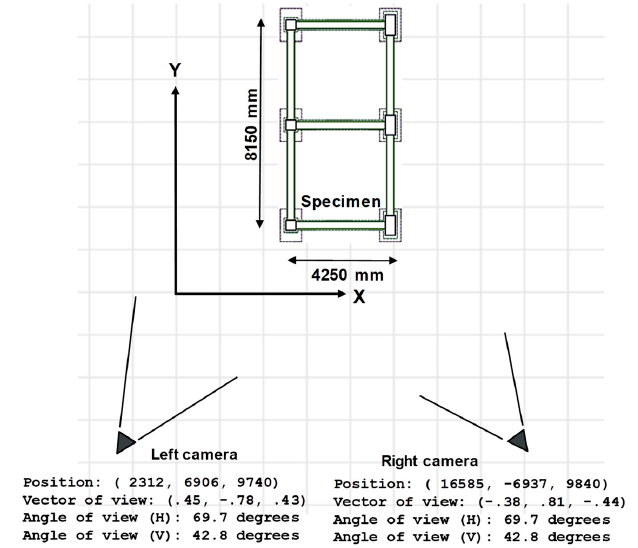
Figure 12. Camera positions and viewing directions based on calibrated extrinsic parameters. Calibrated extrinsic parameters represent the positions and orientations of cameras in the experiment.